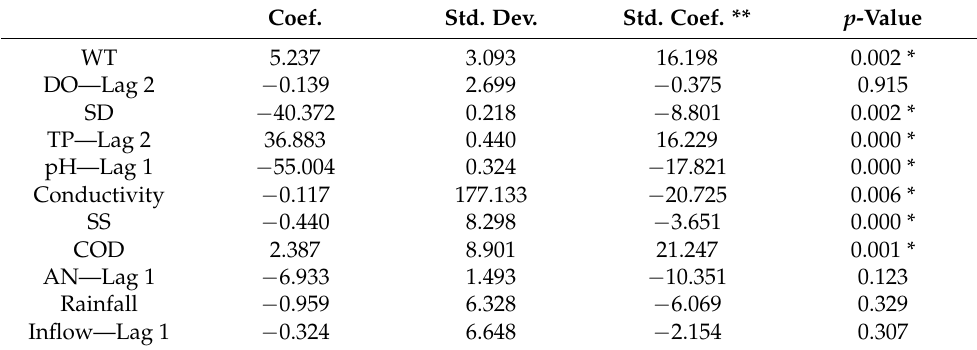
Table 10. Standardization coefficients of variables measured at the Fongshan Reservoir.